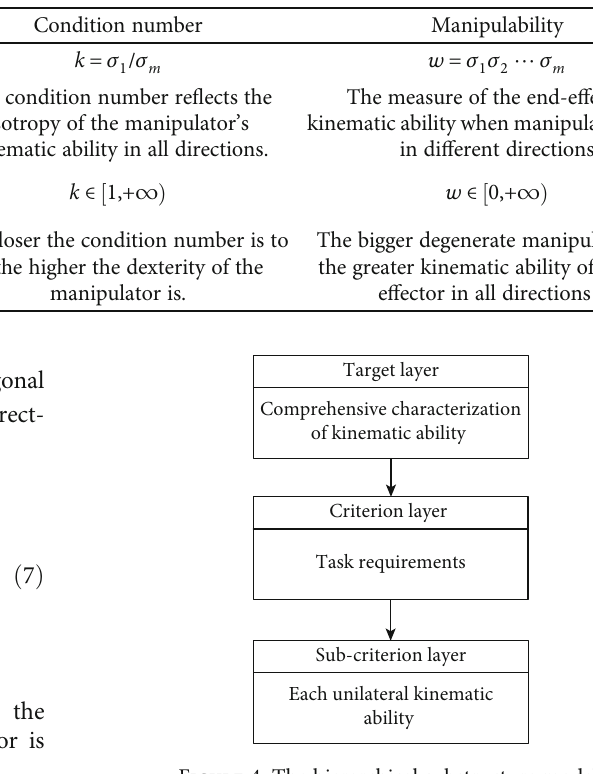
Figure 4: The hierarchical substructure